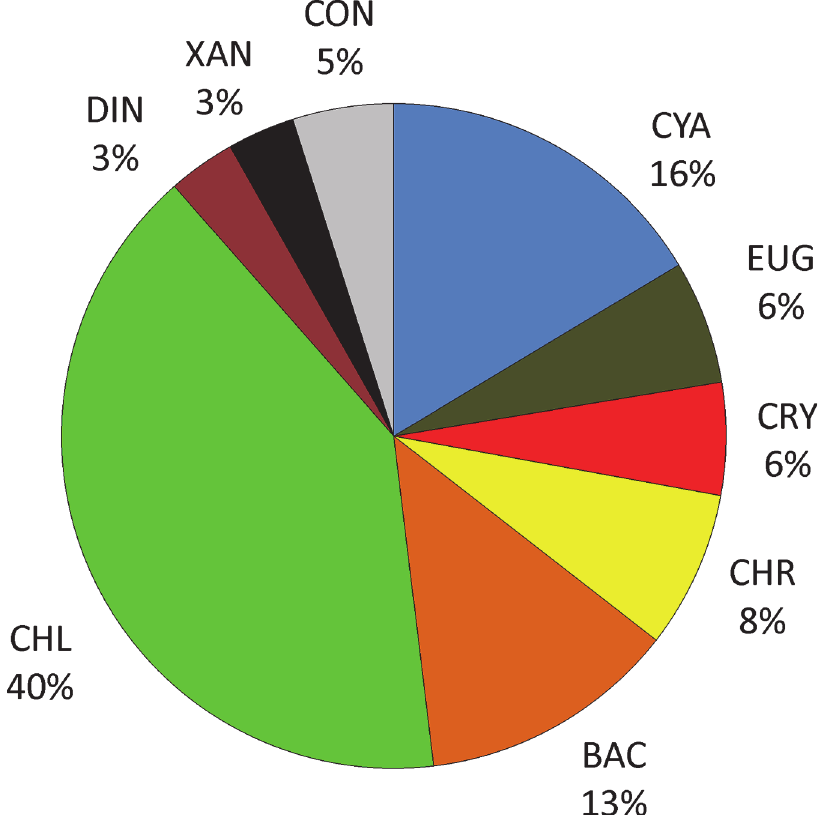
Fig 3. The participation of taxa belonging to main algal groups identified in Malta ń ski Reservoir. CYA-Cyanobacteria, EUG-Euglenophyceae, CRY-Cryptophyceae, CHR-Chrysophyceae, BAC-Bacillariophyceae, CHL-Chlorophyceae, DIN-Dinophyceae, XAN-Xantophyceae, CON-Conjugatophyceae.